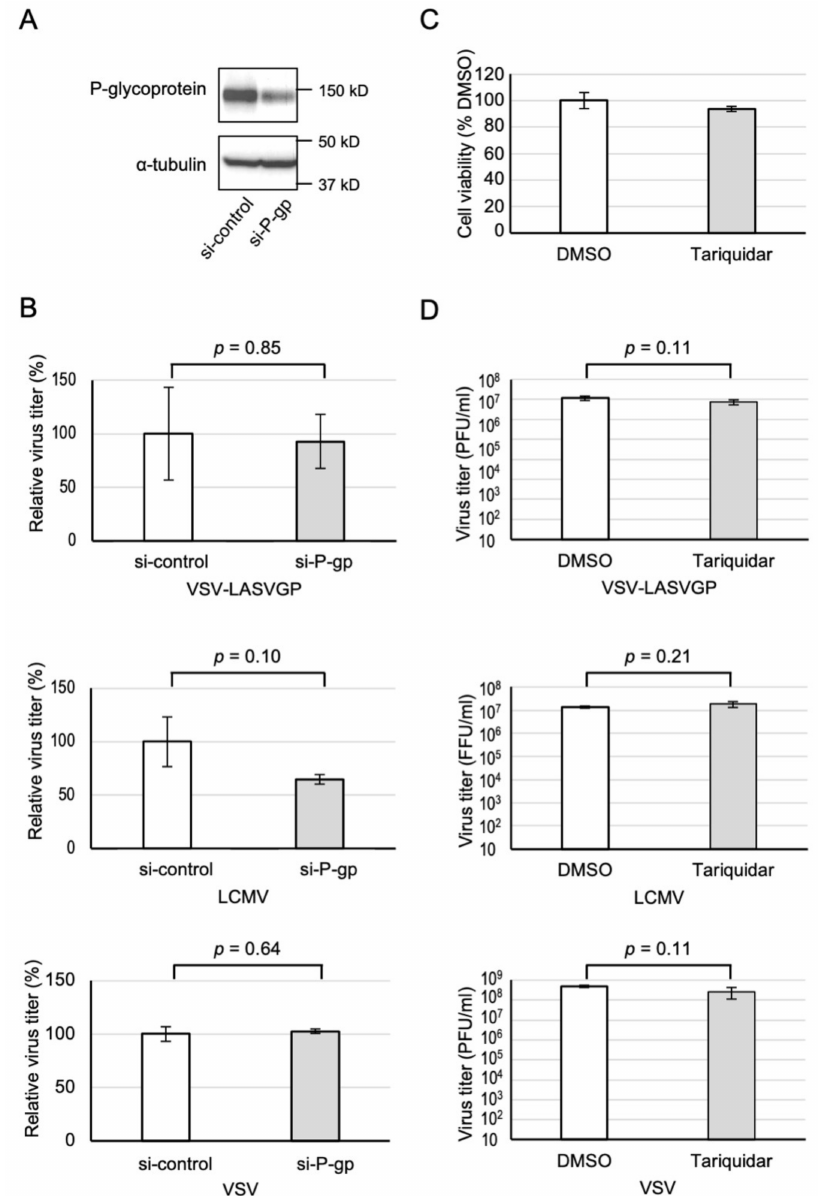
Figure 4. Effects of P-gp knockdown and another P-gp inhibitor on virus replication. ( A ) Vero cells were transfected with a control siRNA or an siRNA against P-gp, and the cell lysates were collected for Western blotting at 24 h post-infection (hpi). ( B ) Vero cells were transfected with a control siRNA or an siRNA against P-gp, followed by infection with 1000 plaque-forming units (PFU) of pseudotyped vesicular stomatitis virus harboring LASV glycoprotein (VSV-LASVGP), 1000 focus-forming units of lymphocytic choriomeningitis virus (LCMV), or 1000 PFU of VSV. At 24 hpi (VSV-LASVGP and VSV) or 48 hpi (LCMV), the supernatants were collected for virus titration. Welch’s t-test was used to compare the two groups and p values are indicated. The values indicate means ± standard deviation of the representative experiment in biological triplicates from two independent experiments. ( C , D ) Vero cells treated with 10 µ M Tariquidar were infected with either VSV-LASVGP, LCMV, or VSV at a multiplicity of infection (MOI) of 0.01. At 24 hpi (VSV-LASVGP and VSV) or 48 hpi (LCMV), the supernatants were collected for virus titration. ( C ) Cell viability was measured by a CellTiter- Glo assay after 24 h of treatment with 10 µ M Tariquidar. Welch’s t-test was used to compare the two groups and p values are indicated. The values indicate means ± standard deviation of the representative experiment in biological triplicates from three independent